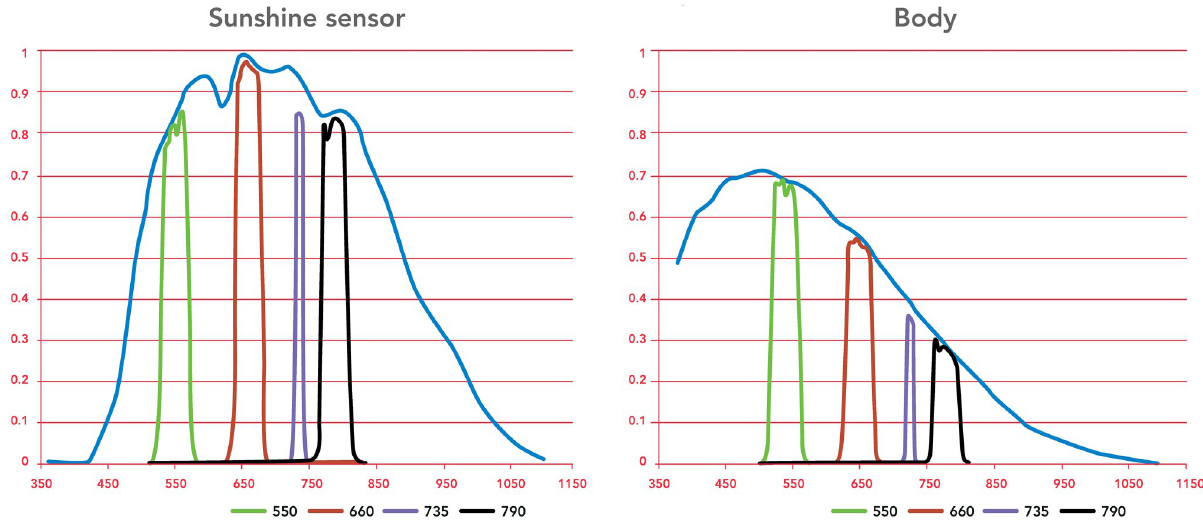
Fig 2. Sequoia sensitivities against wavelengths (nm) for the camera body and for the sunshine sensor: Green (550 nm), red (660 nm), red edge (735 nm), NIR (790